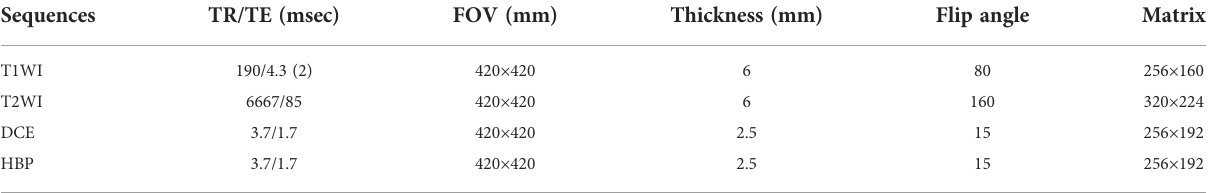
TABLE 1 Sequences and parameters of Gd-BOPTA dynamic-enhanced MRI.